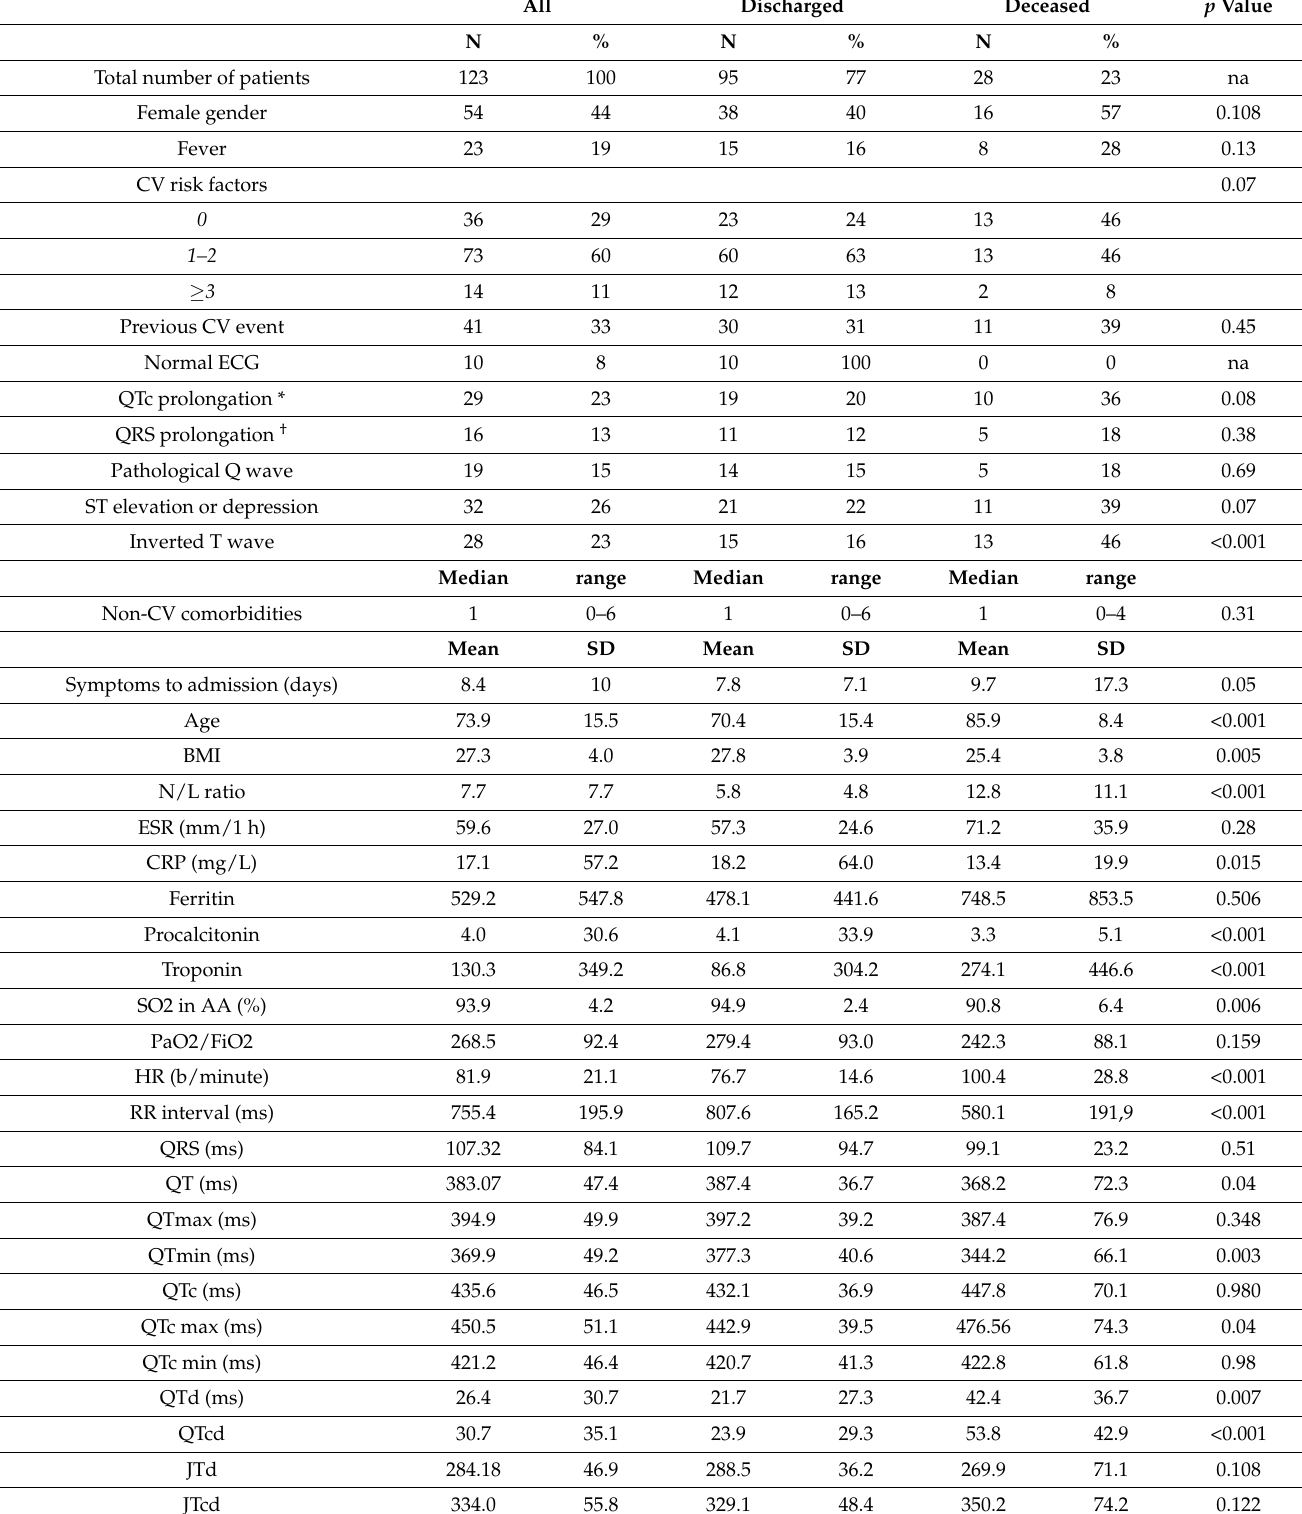
Table 1. Baseline characteristics of the entire patient cohort (N = 123) and comparison of baseline characteristics according to the outcome (N = 95 discharged vs. N = 28